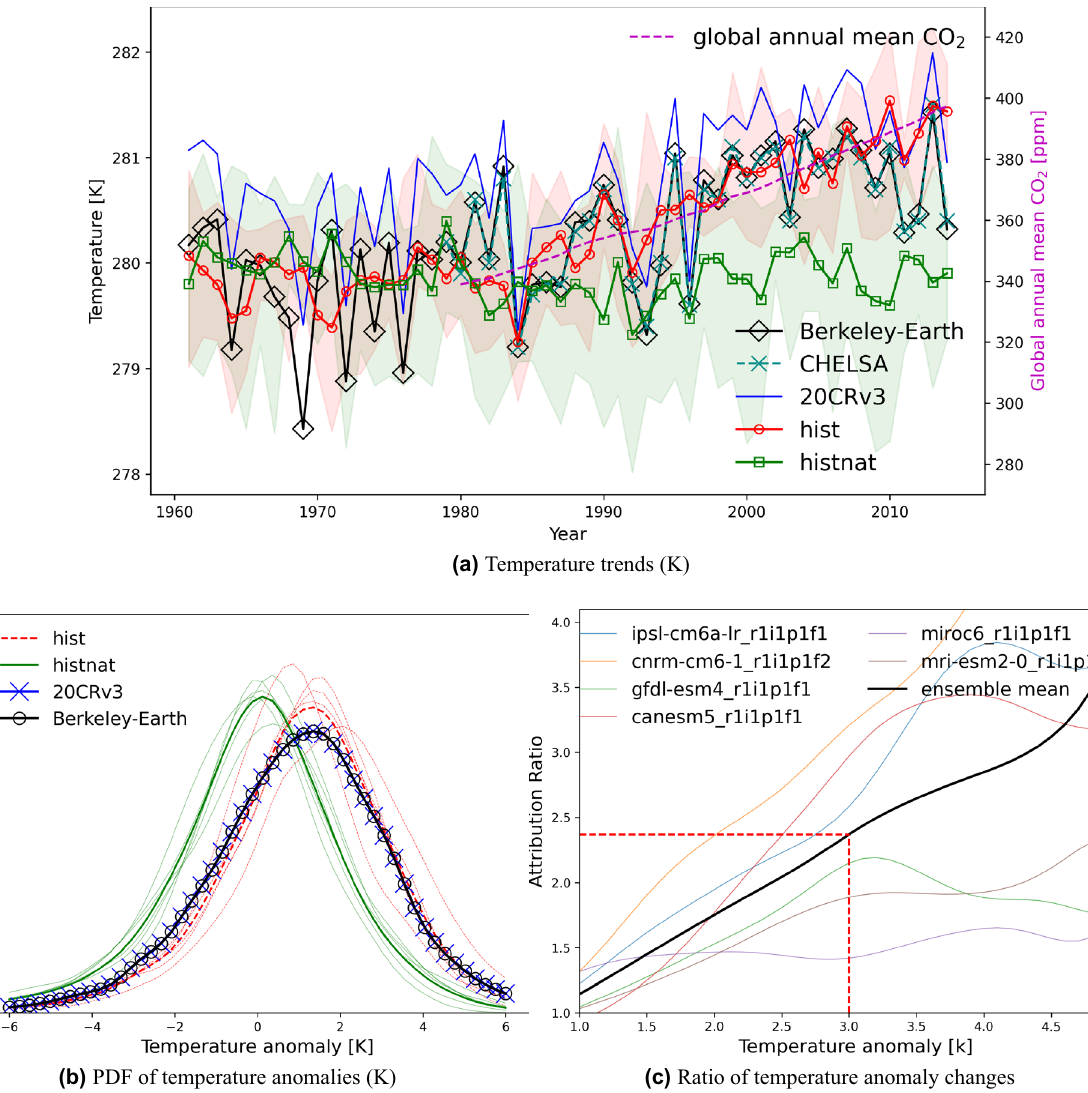
Figure 6. ( a ) Annual temperature time-series over Central Asia for the Berkeley-Earth data set 42 (black line), historical models’ ensemble mean (red line), hist-nat models’ ensemble mean (green line) and cumulative global annual mean CO 2 concentration (ppm); ( b ) Normalized probability density functions of daily temperature anomalies (1995–2014 w.r.t. 1961–1980) for hist (solid red) and hist-nat (solid green), ( c ) ratio of daily P ( tas hist ) temperature anomalies’ PDF (i.e., P ( tas hist − nat ). Shadings in ( a ) show the ensembles’